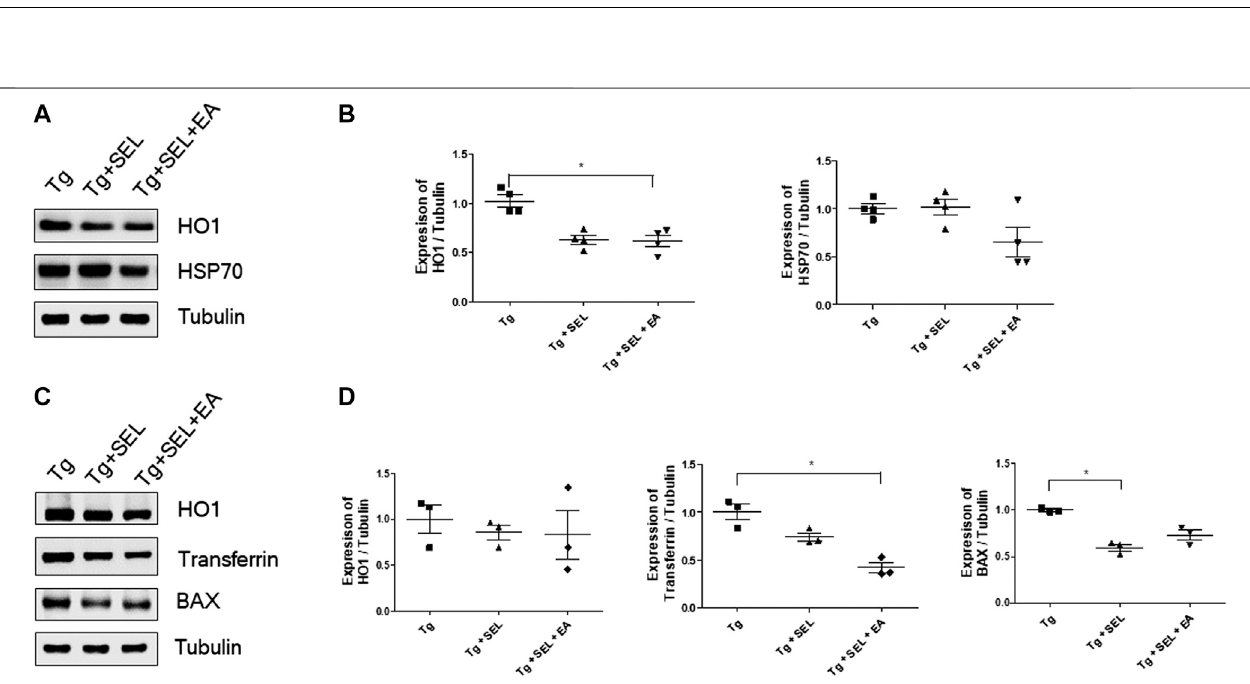
Frontiers in Pharmacology |